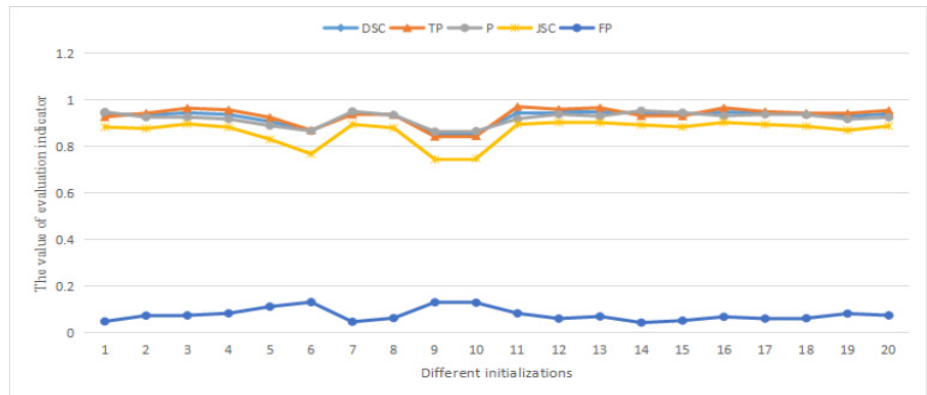
Figure 1. Segmentation results of our model with 5 different initial contours. ( a ) original image with initial contours; ( b ) the corresponding segmentation results of ( a ); ( c ) original image with initial contours, ( d ) the corresponding segmentation results of ( c ); ( e ) original image with initial contours; ( f ) the corresponding segmentation results of ( e ); ( g ) original image with initial contours; ( h ) the corresponding segmentation results of ( g ); ( i ) original image with initial contours; ( j ) the corre- sponding segmentation results of ( i ).